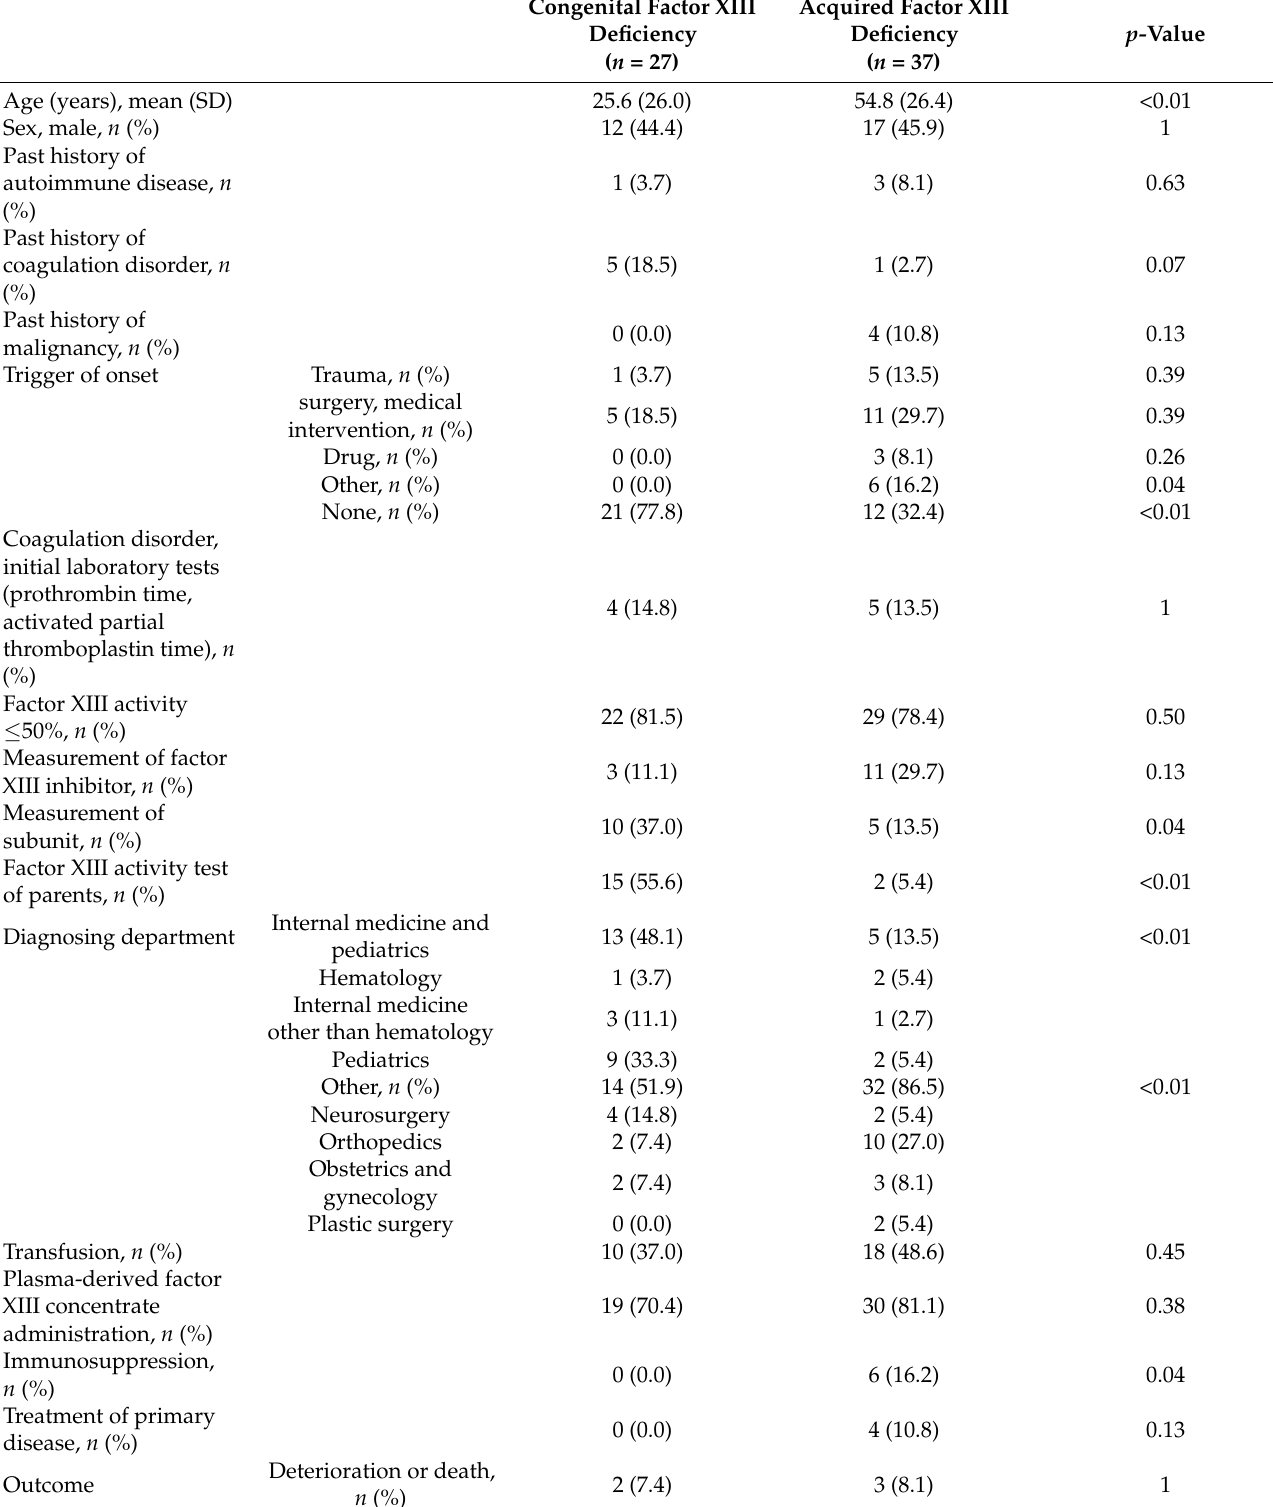
Table 5. Patients’ background